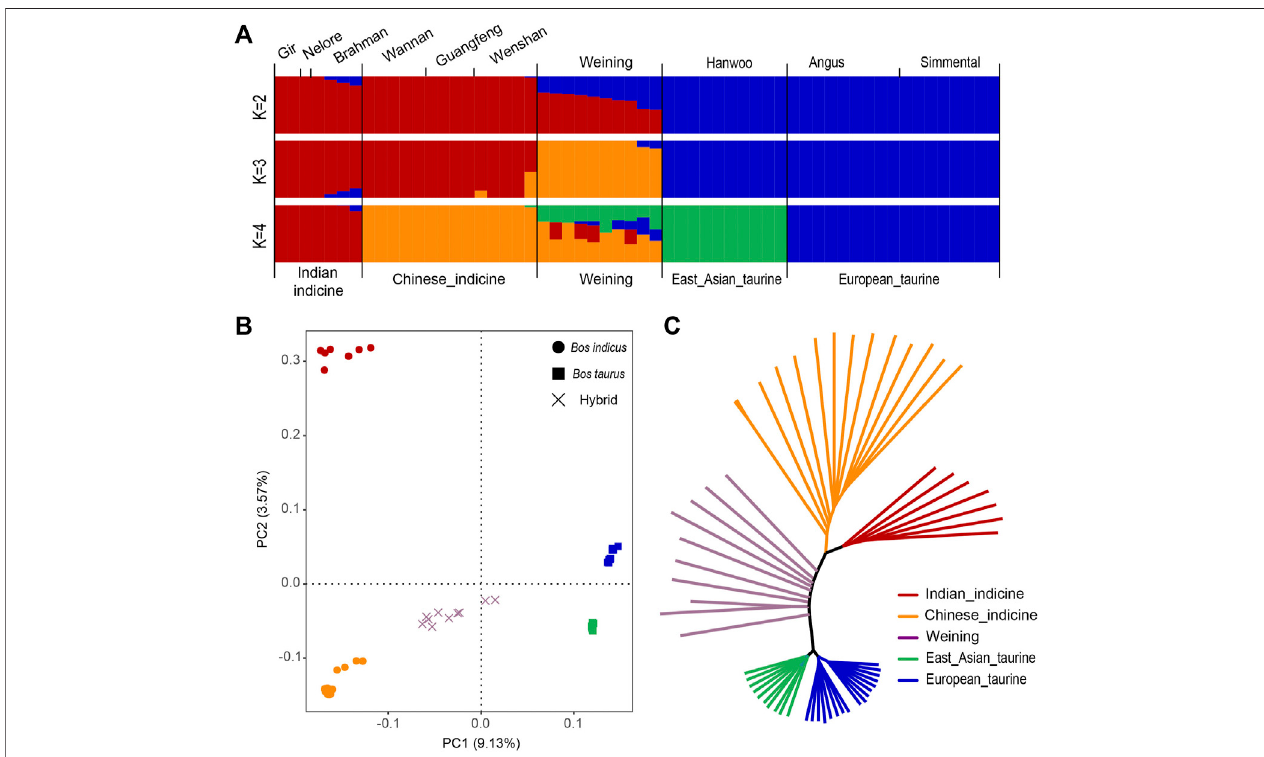
FIGURE 2 | Population structure and relationships of Weining in comparison to several possible ancestral breeds. (A) . Model-based clustering of cattle breeds using ADMIXTUREwith K =2 and K = 4. Breeds are colored by geographic regions and labeled with breedname. (B) . Principal componentanalysis of10 cattlebreeds. (C) . Neighbor-joining tree of the relationships between the ten cattle breeds (58